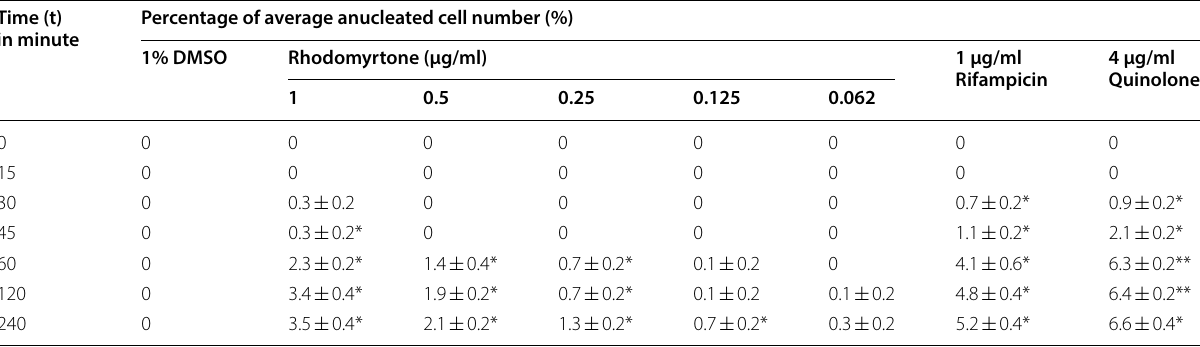
Table 2 Percentage of the average anucleated cell number in rhodomyrtone treated-recombinant Streptococcus suis ParB-GFP